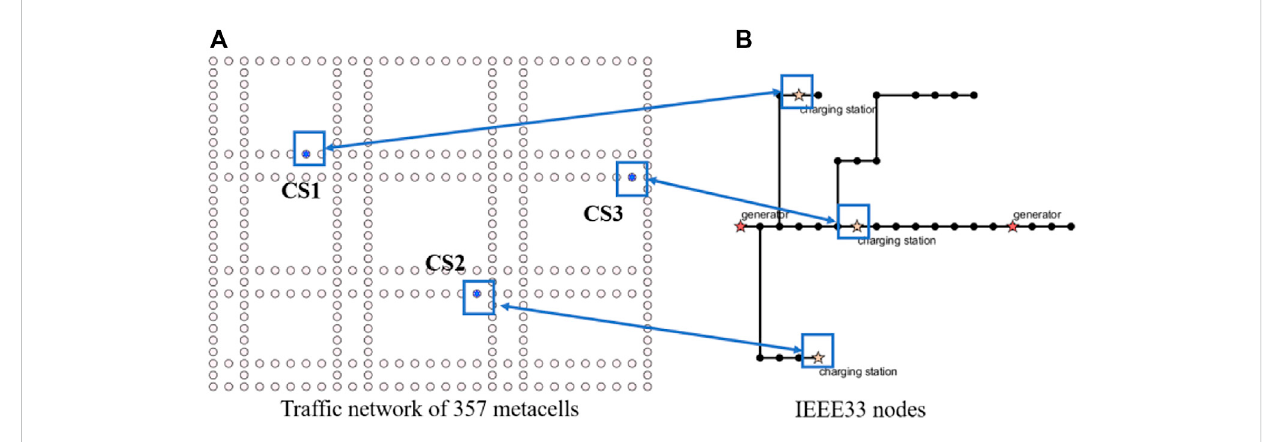
FIGURE 4 Coupling of the traf fi c – power system.